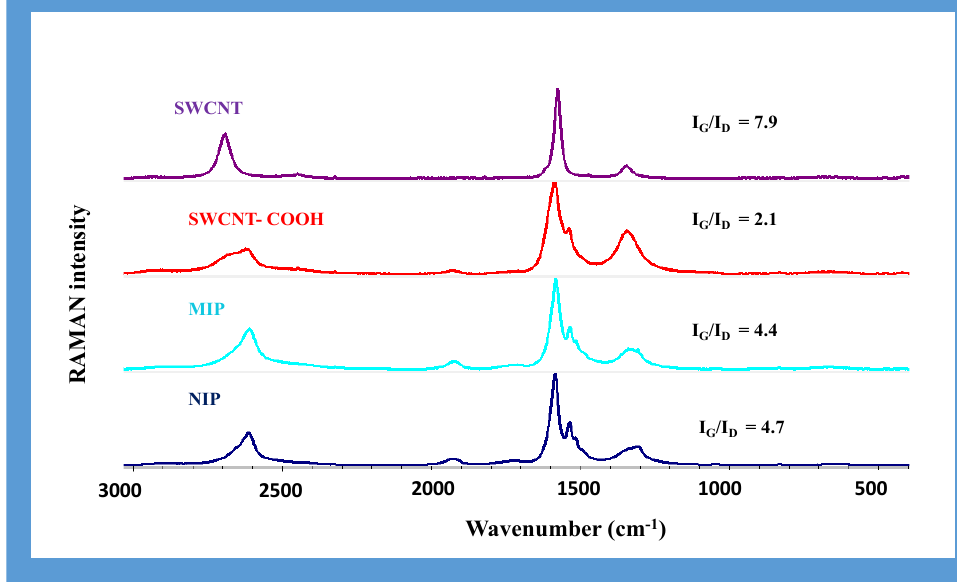
Figure 2. Raman spectra of SWCNT, CNT − COOH and MIP and NIP. Carbon nanotubes are rolled-up graphene sheets that have been wound into tubes.